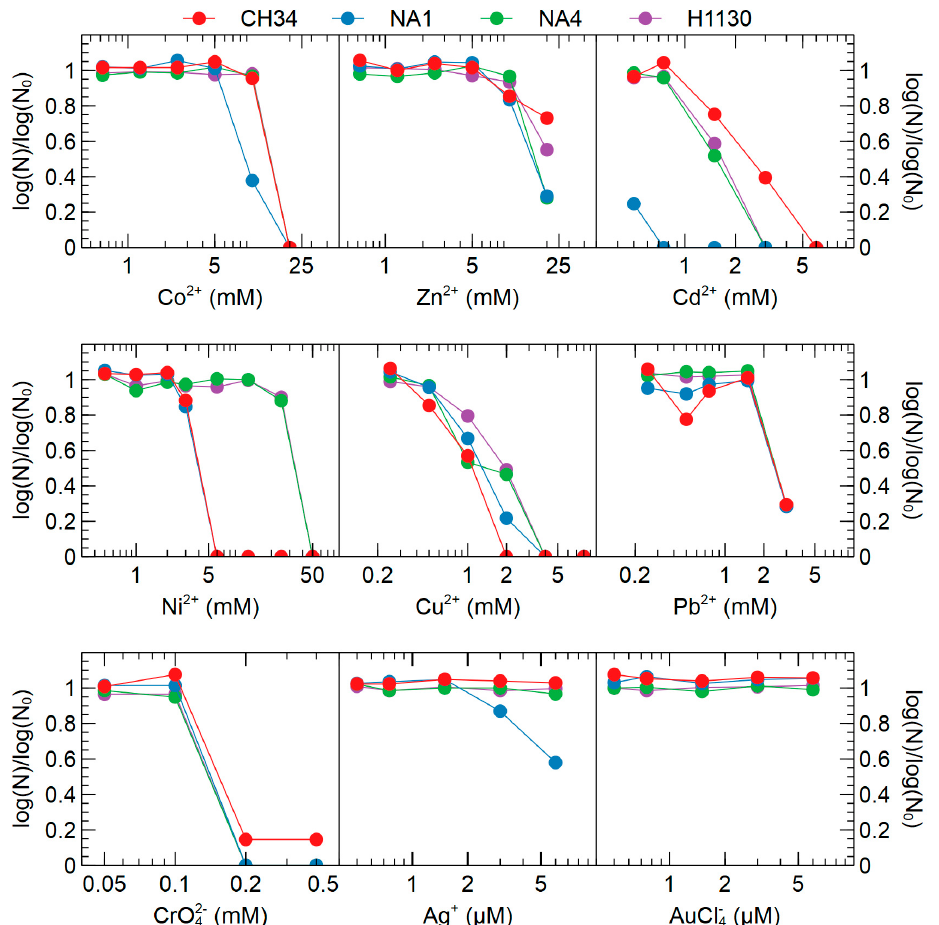
Figure 8. Viable count of C. metallidurans CH34, NA1, NA4 and H1130 grown in the presence of various metal concentrations (Table S2). Data are presented as log(N)/log(N 0 ) in function of metal concentration, with N and N 0 the colony forming units (CFUs) in the presence and absence (control) of metal, respectively.